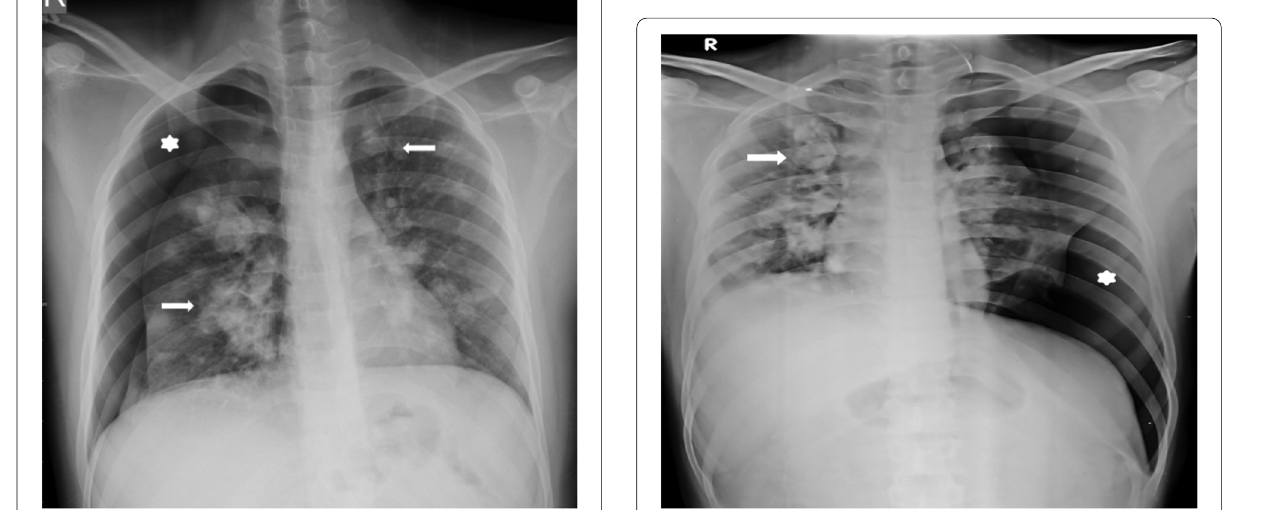
Fig. 2 Right pneumothorax, bilateral metastatic pulmonary nodules Fig. 3 Left pneumothorax with metastatic pulmonary